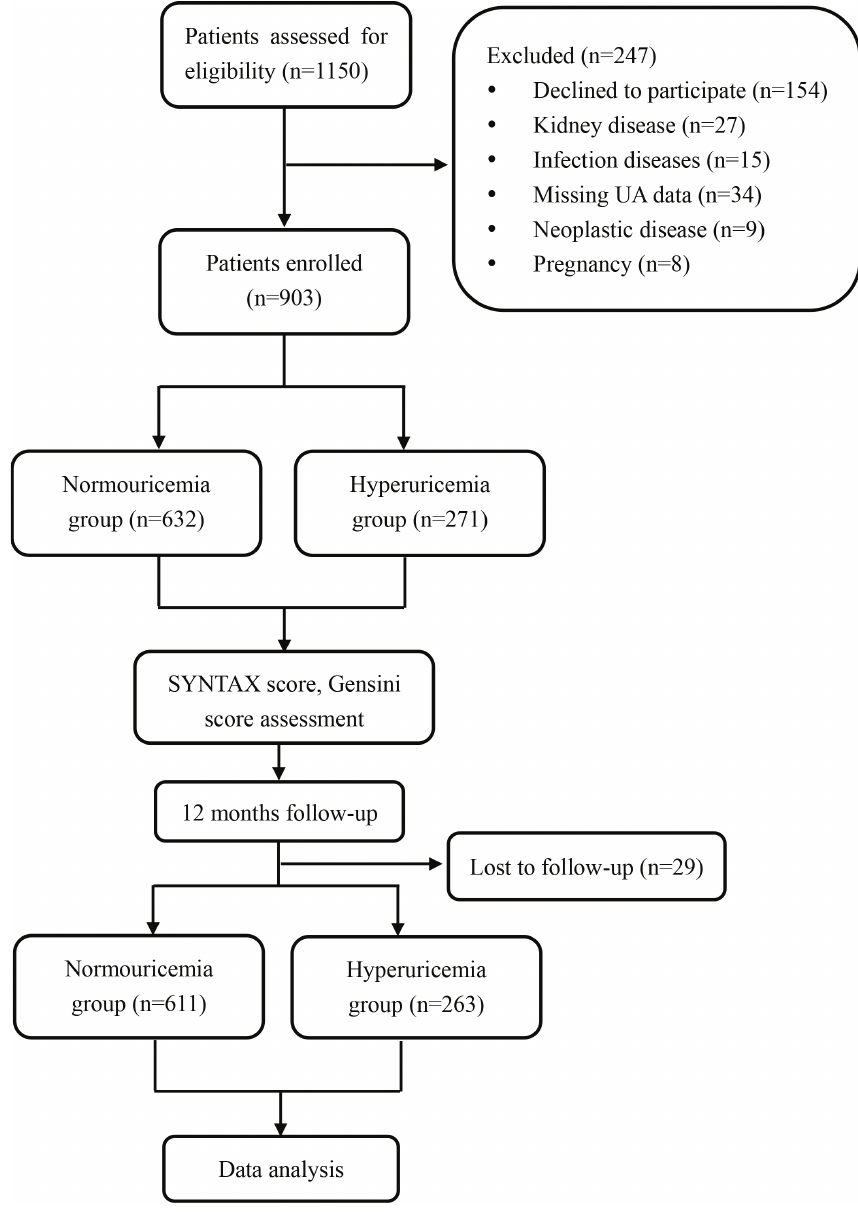
Fig. 1. Participant flow